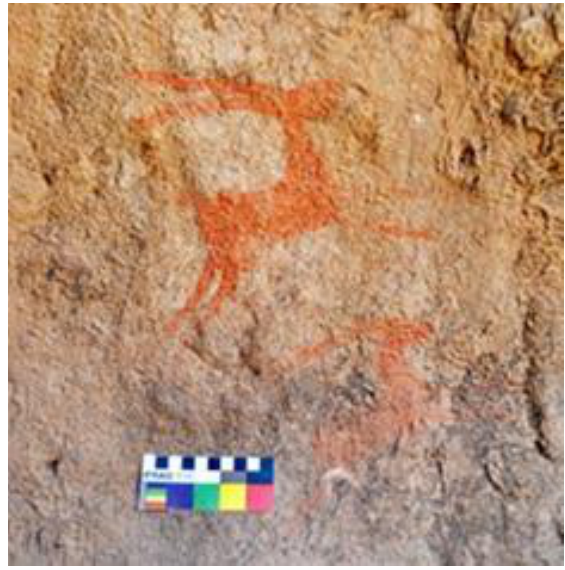
Figure 10. Kuh-e-Donbeh, Site IV.